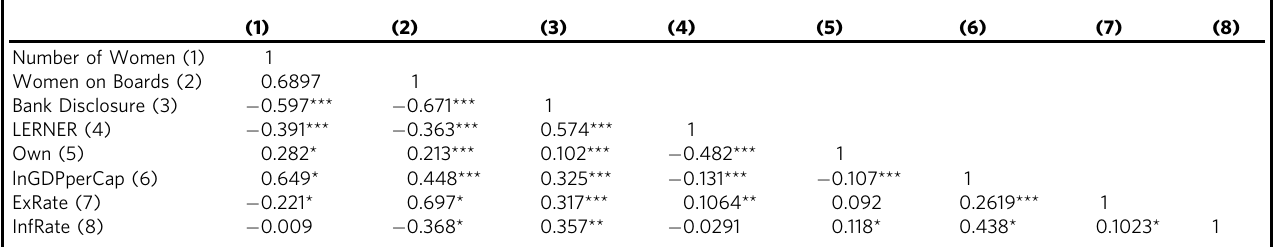
Table 3 Pairwise correlation matrix and the signi fi cance of the